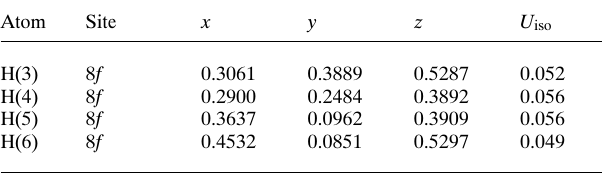
Table 2. Atomic coordinates and displacement parameters (in Å 2 )